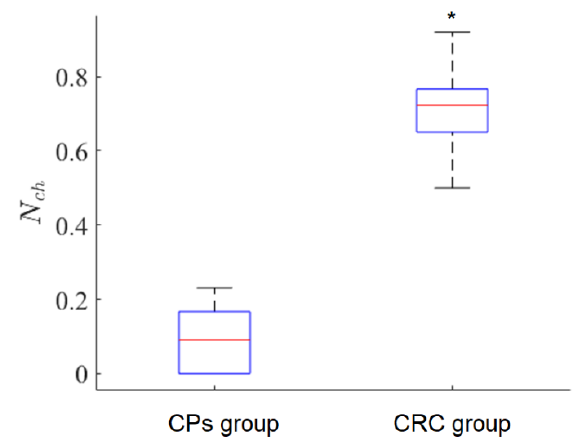
Figure 10. A box diagram for N ch values for CP and CRC patient groups, * p -value is 3.35 · 10 − 5 . Here, N ch is the relative number of CRC-associated exosomes in the FLIM dataset calculated according to Formula